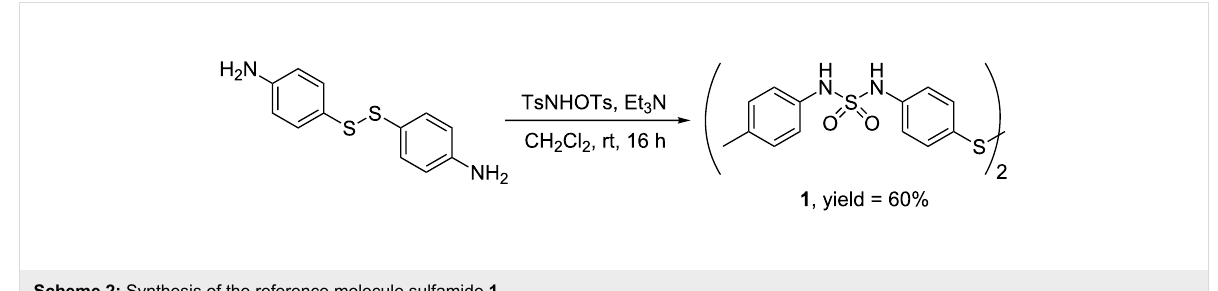
Scheme 2: Synthesis of the reference molecule sulfamide 1 .